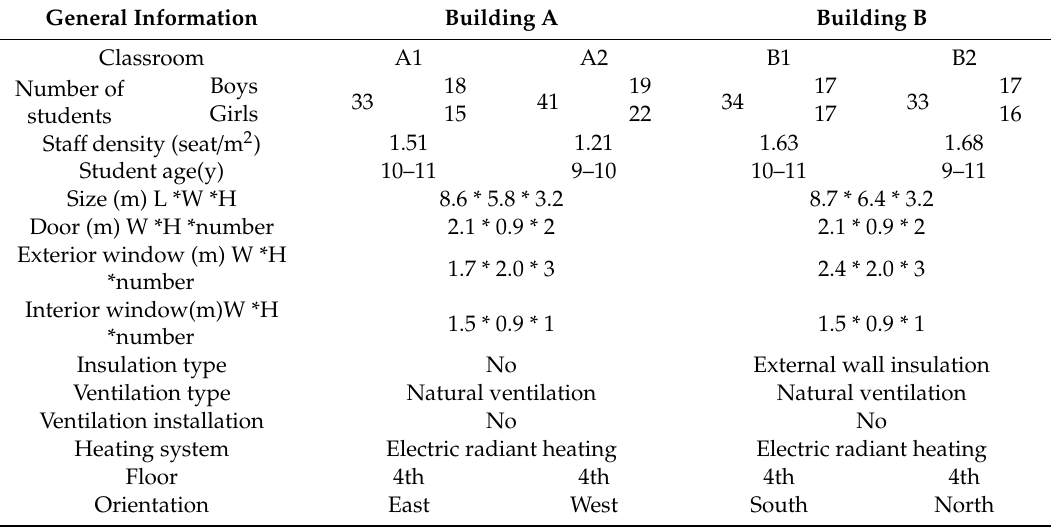
Table 1. Information on the selected classrooms.